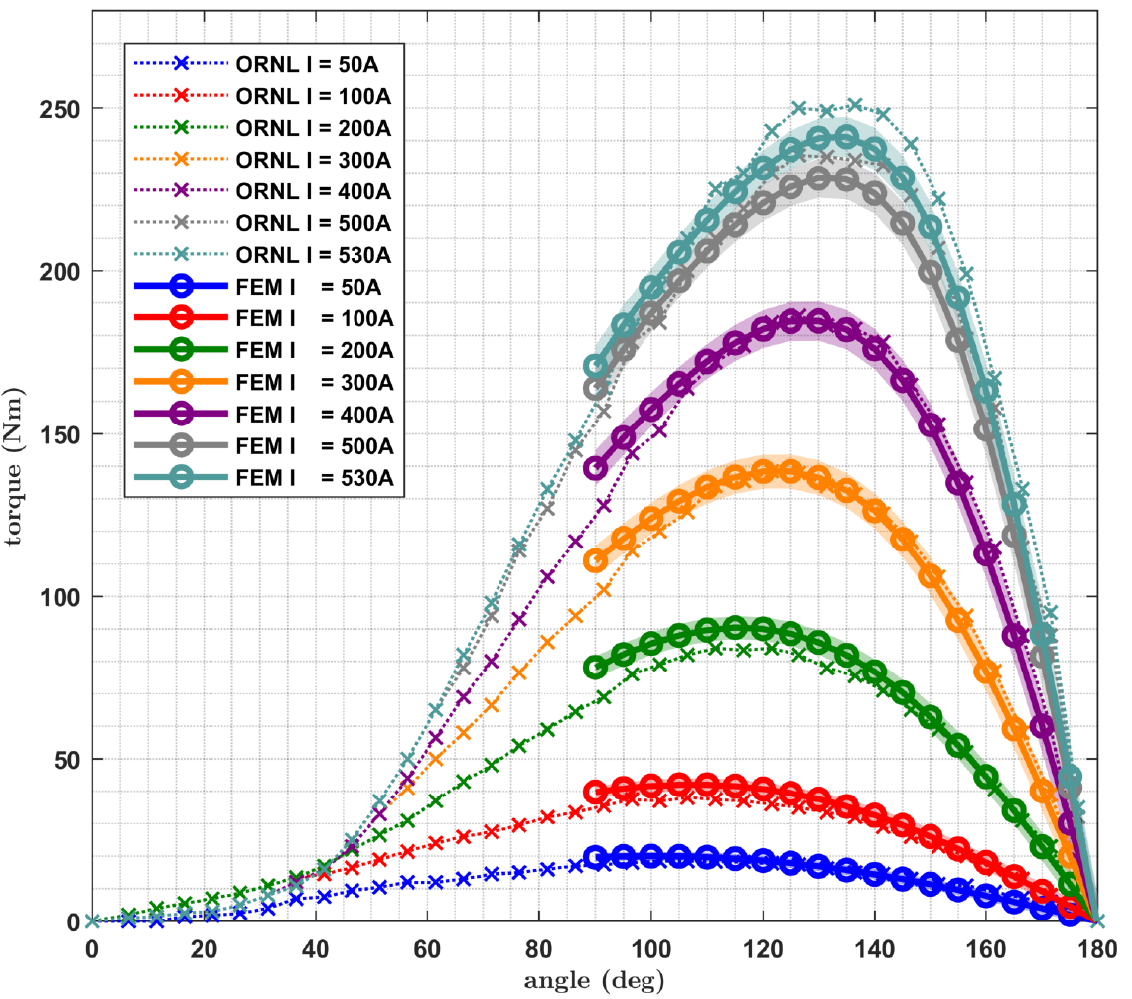
Figure 7. Comparison of the experimental locked rotor test results obtained by the Oak Ridge National Laboratory (ORNL) [19] (dotted lines with cross markers) with corresponding values obtained with the FEM model (solid lines with circle markers). Simulation results are averaged over one electrical period and the shaded areas indicate the amount of torque